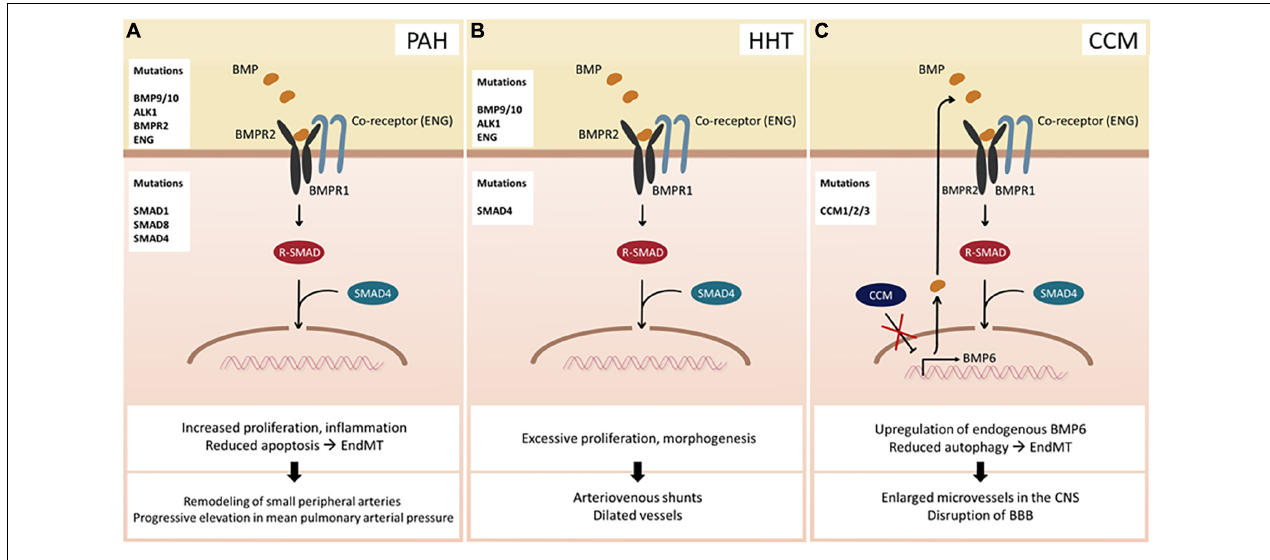
FIGURE 2 | Consequences of BMP signaling dysfunction. (A) Pulmonary arterial hypertension (PAH) can occur due to mutations in BMP ligands, receptors, co-receptors, and SMAD proteins. (B) Hereditary hemorrhagic telangiectasia (HHT) arises upon mutation of BMP9/10, ALK1, ENG, or SMAD4. (C) Cerebral cavernous malformation (CCM) develops when one of the CCM proteins is mutated. Hence, transcriptional activity of BMP6 increases leading to an enhanced BMP signaling. Abbreviations : CNS, central nervous system; BBB, blood–brain